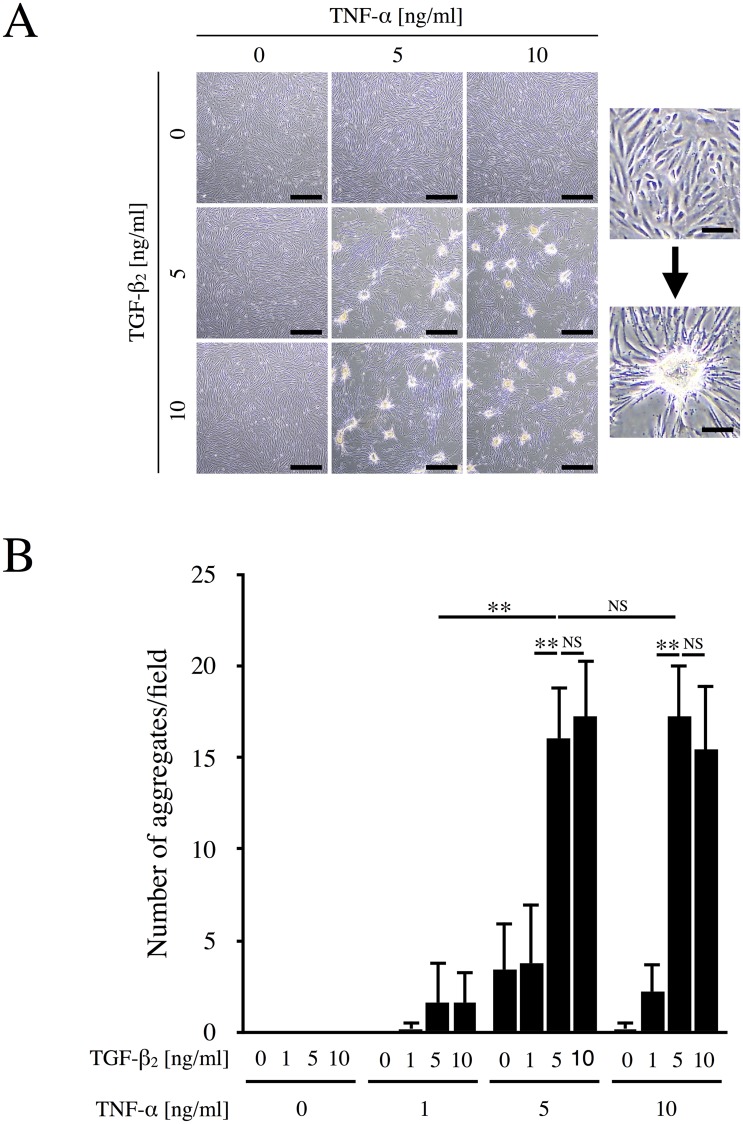
TNF-α/TGF-β2-induced aggregate formation by ARPE-19 cells.(A) ARPE-19 cells were cultured in the absence or presence of the indicated concentrations of TNF-α and TGF-β2 for 48 h. Left panel, Representative photos. Right panel, Magnified images of the cells growing as a flat monolayer or piled up in aggregates. Scale bars = 200 μm (left panel) and 40 μm (right panel). (B) The number of cellular aggregates per microscopic field was counted and analyzed (n = 5). **, p < 0.01; NS, not significant. Error bars, S.E.